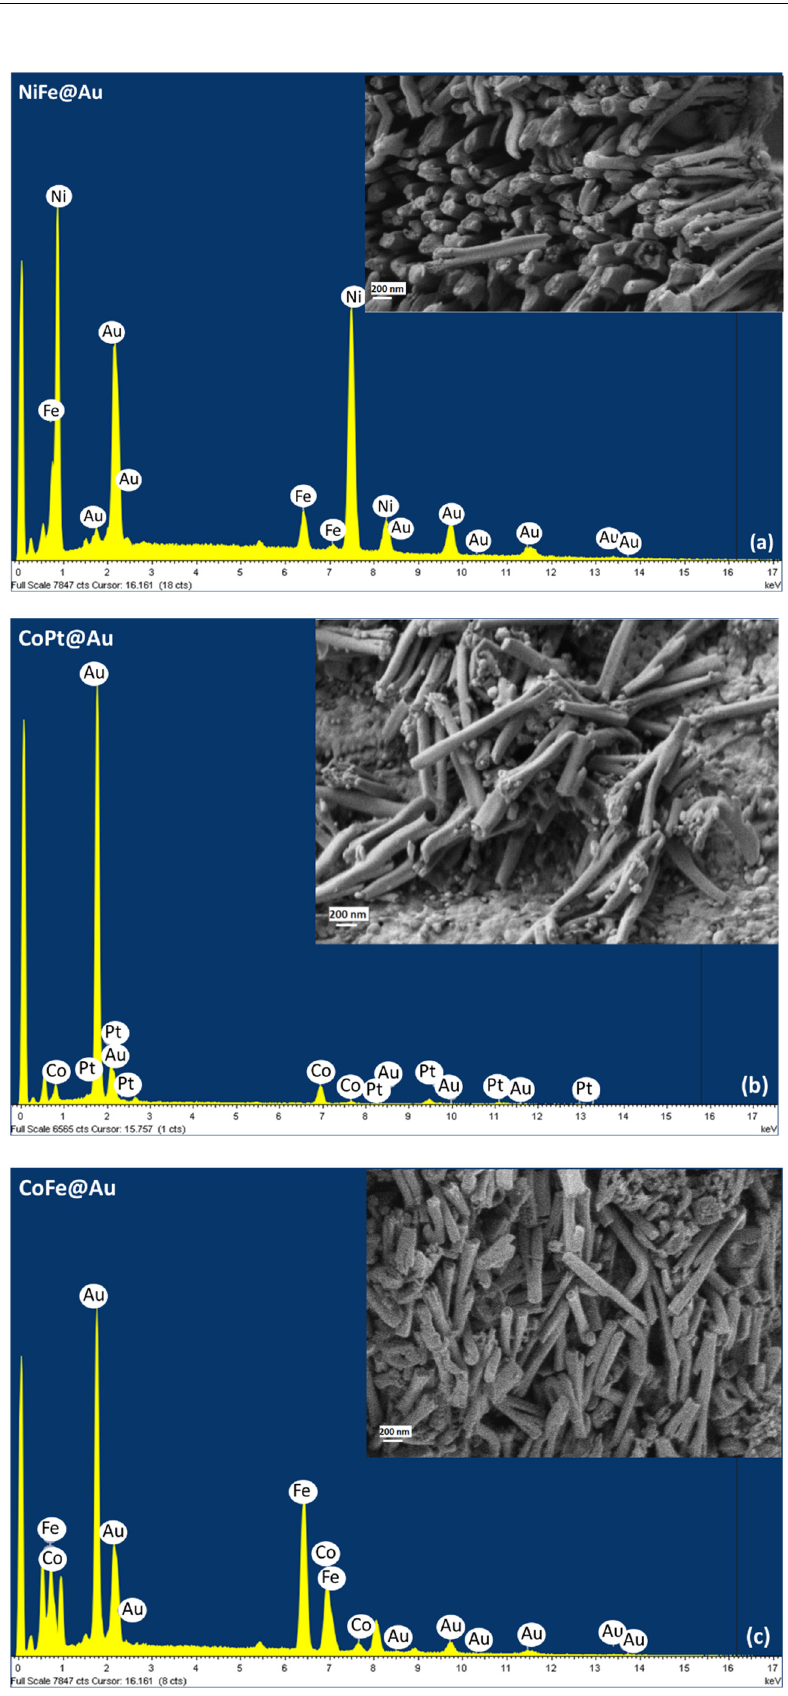
Figure 5. EDX spectra and SEM micrograph images of as-prepared core–shell nanowires: ( a